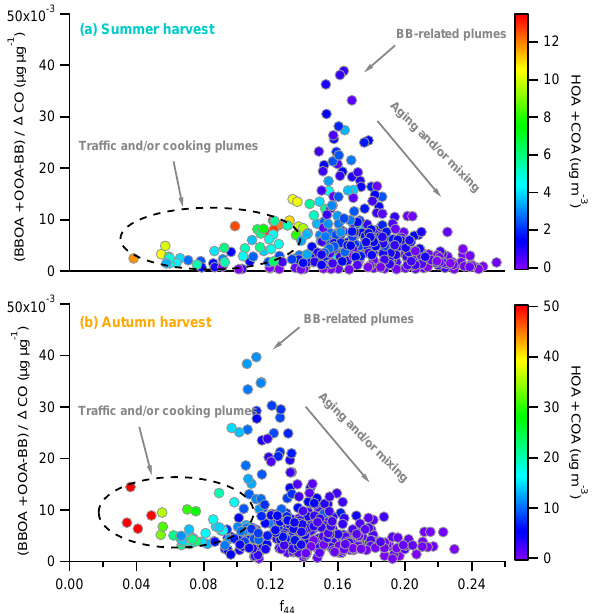
Figure 10. The (BBOA + OOA-BB) /(cid:49) CO ratio as a function of f 44 during the summer and autumn harvest. Colored by the HOA + COA mass concentrations for the summer and autumn har- vest. = m/z 60 – background value of f 60 × OA). As shown in Fig. 5b, the strong correlations ( r 2 = 0 . 95, r 2 = 0 . 98, and r 2 = 0 . 97) between the BBOA and (cid:49)m/z 60 with the simi- lar slopes, i.e., 16.3 for summer, 14.6 for autumn, and 15.1 for the total harvest seasons, were observed. The OOA-BB mass loadings also show the high correlations with (cid:49)m/z 60 ( r 2 = 0 . 95 and r 2 = 0 . 97), but with very different slopes (74.8 and 64.4) during the summer and autumn harvest, re- spectively (Fig. 5b). Aiken et al. (2009) also found that BBOA strongly correlated with (cid:49) m/z 60 mass loadings ( r 2 = 0 . 91, slope = 34) during the BB/wood-smoke periods in Mexico City. Furthermore, Lee et al. (2010) obtained a strong relationship between BBOA and m/z 60 mass load- ings ( r 2 = 0 . 92, slope = 34.5) through a wildland fuels fire experiment in the lab. Thus, we reconstructed the time se- ries of BBOA to compare the relationship between the ex- tracted BBOA by the PMF model (PMF BBOA) and the esti- mated BBOA. As shown in Fig. S16, an excellent agreement is observed between the identified and reconstructed BBOA concentrations during the total harvest seasons ( r 2 = 0 . 97). Therefore, the BBOA component during the BB periods in urban Nanjing of the YRD region can be estimated with the equation of BBOA = 15.1 × ( m/z 60–0.26 % × OA) for the harvest